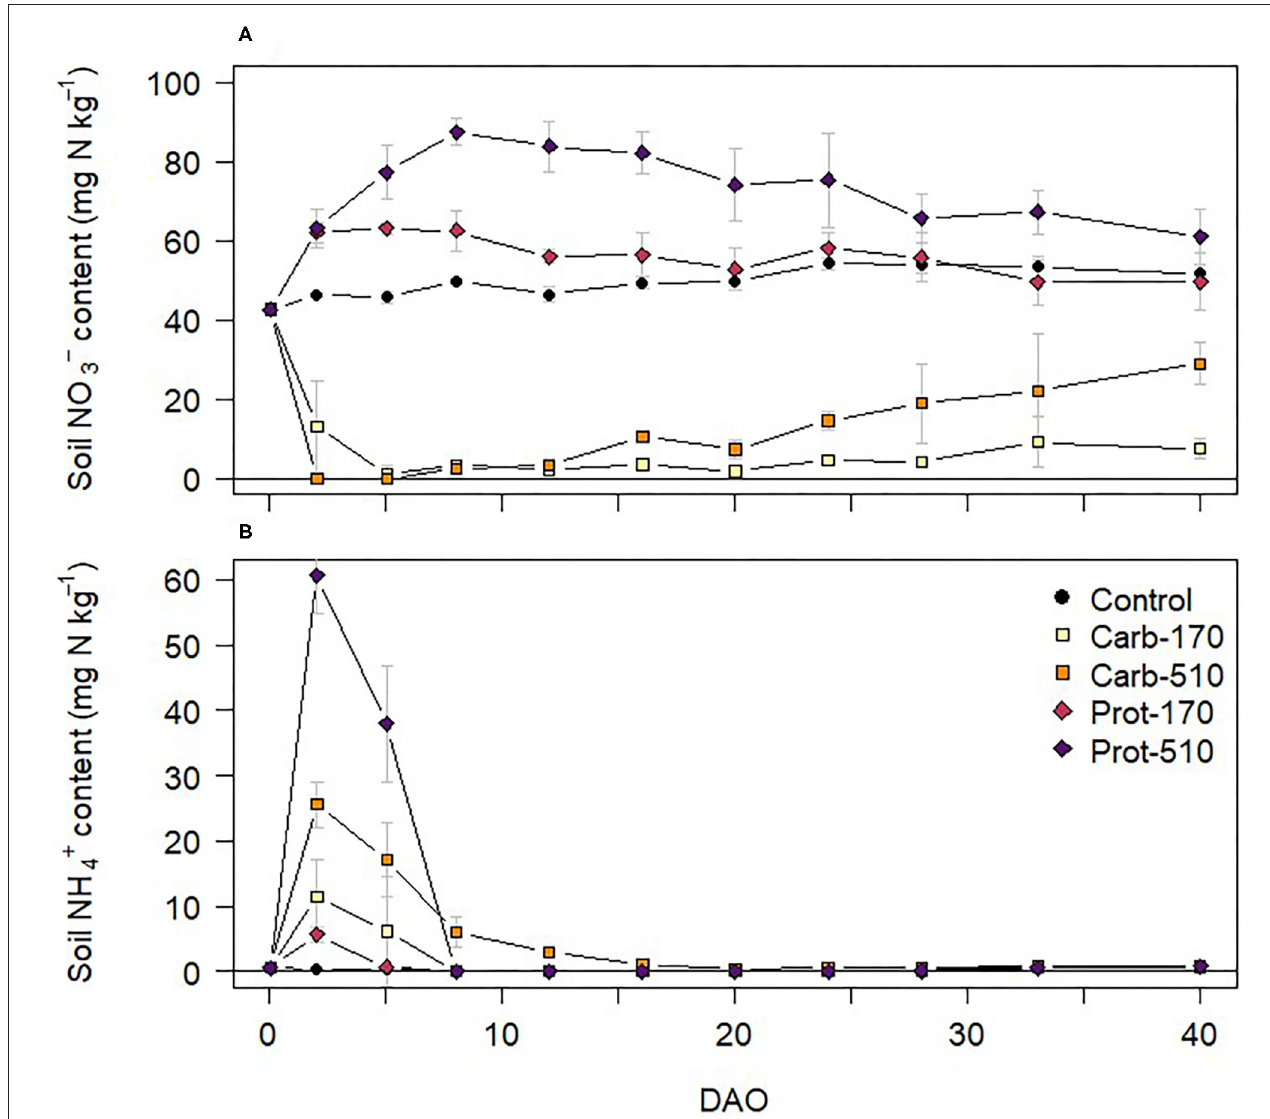
FIGURE 2 | (A) NO − 3 and (B) NH + 4 content in soil during the incubation experiment (mean ± standard deviation for n = 4, for Prot-170 n = 3).